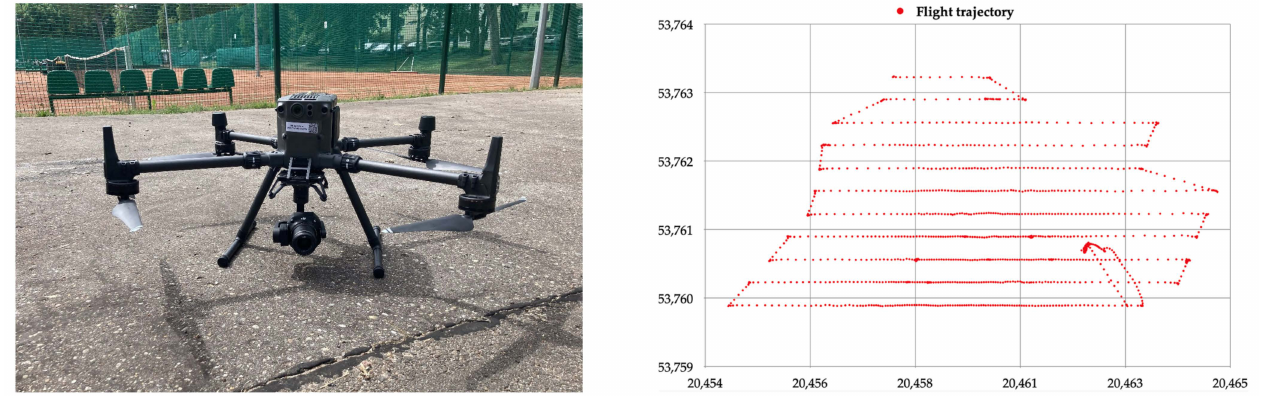
Figure 1. The DJI Matrice 300 RTK used to collect GNSS data ( left ) and the recorded UAV flight trajectory ( right